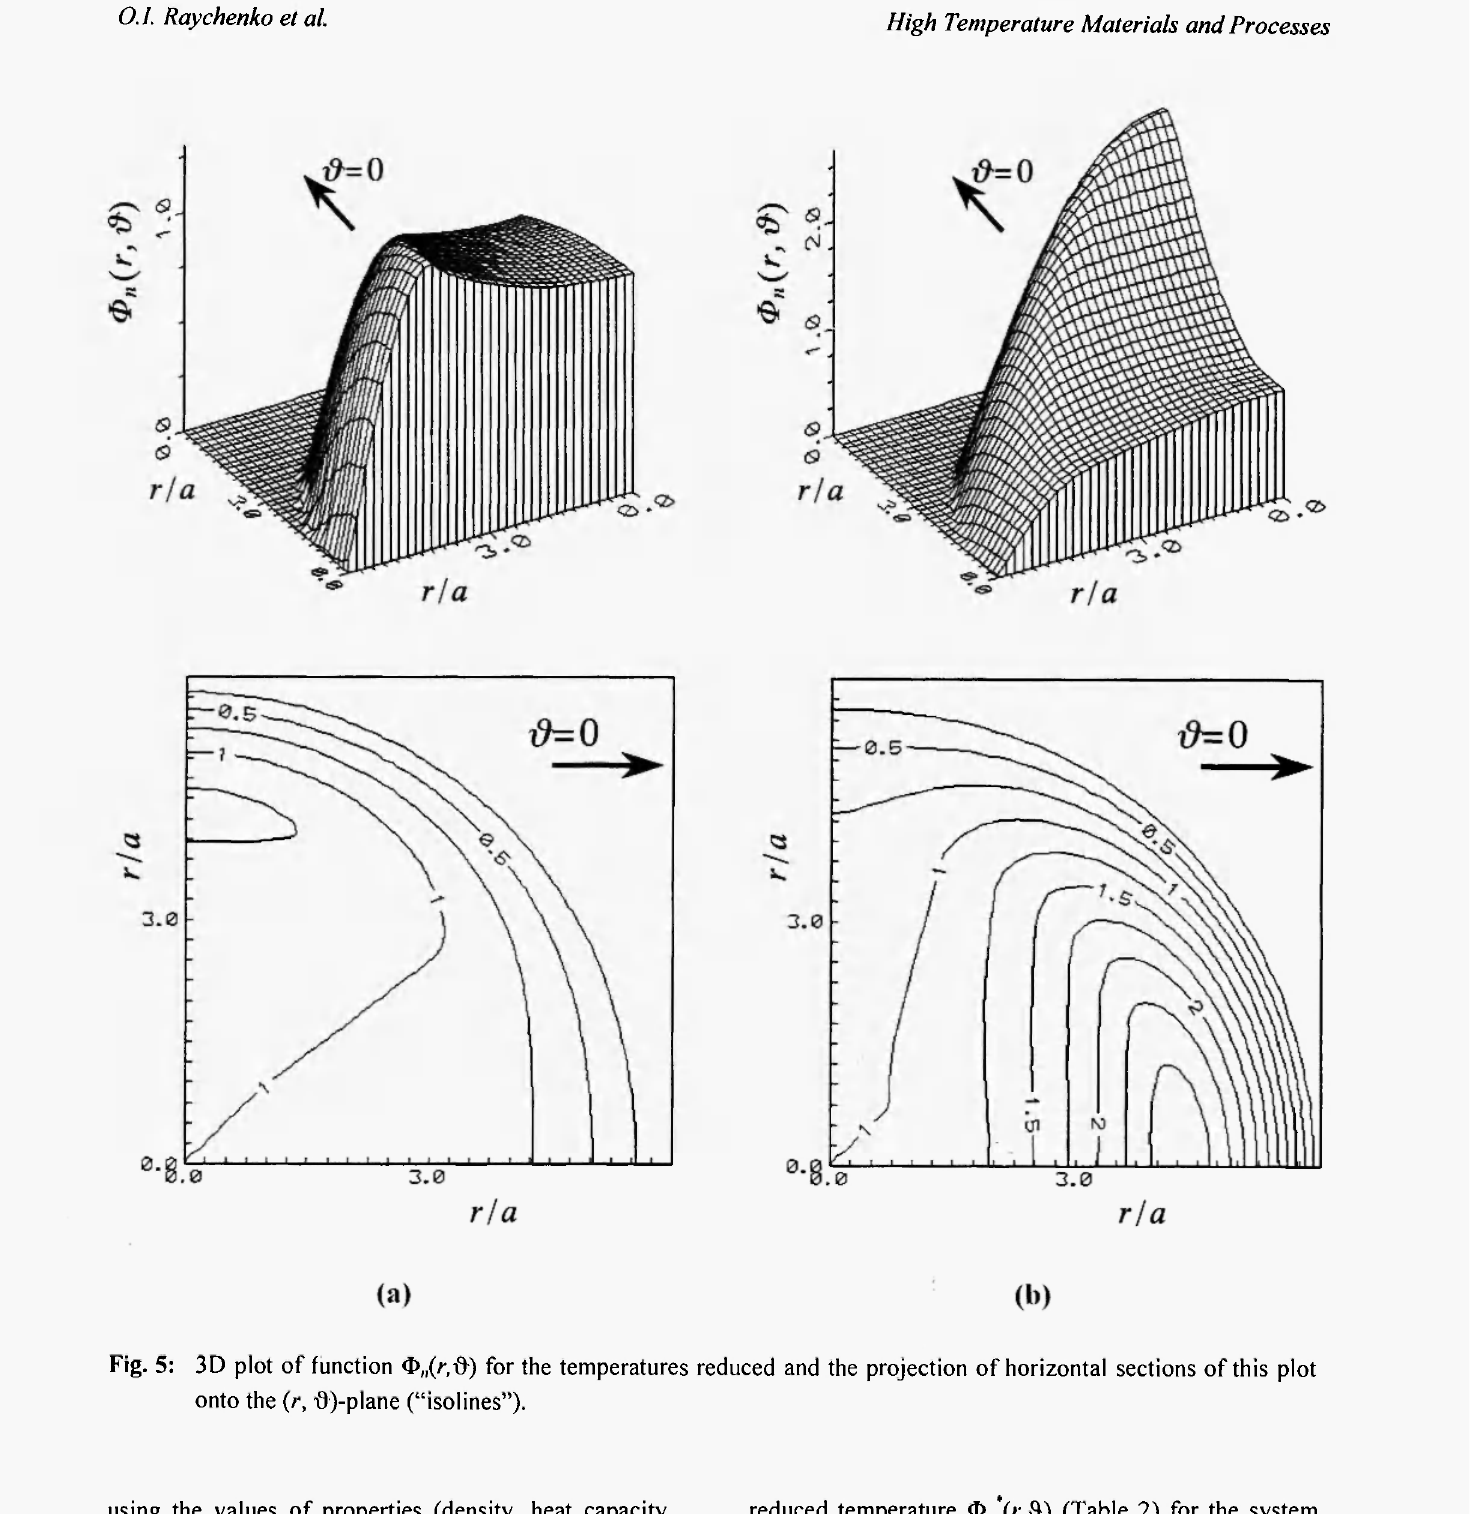
Fig. 5: 3D plot of function Φ„(/-,θ) for the temperatures reduced and the projection of horizontal sections of this plot onto the (r, ft)-plane